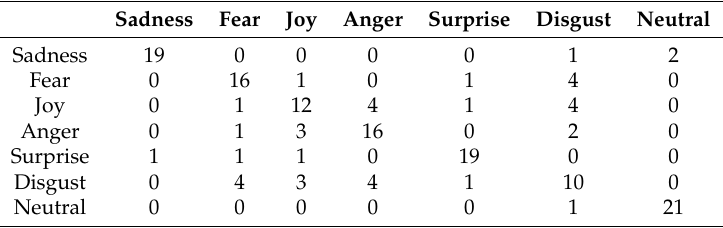
Table A10. P10 actor confusion matrix from the RekEmozio dataset in the second phase.